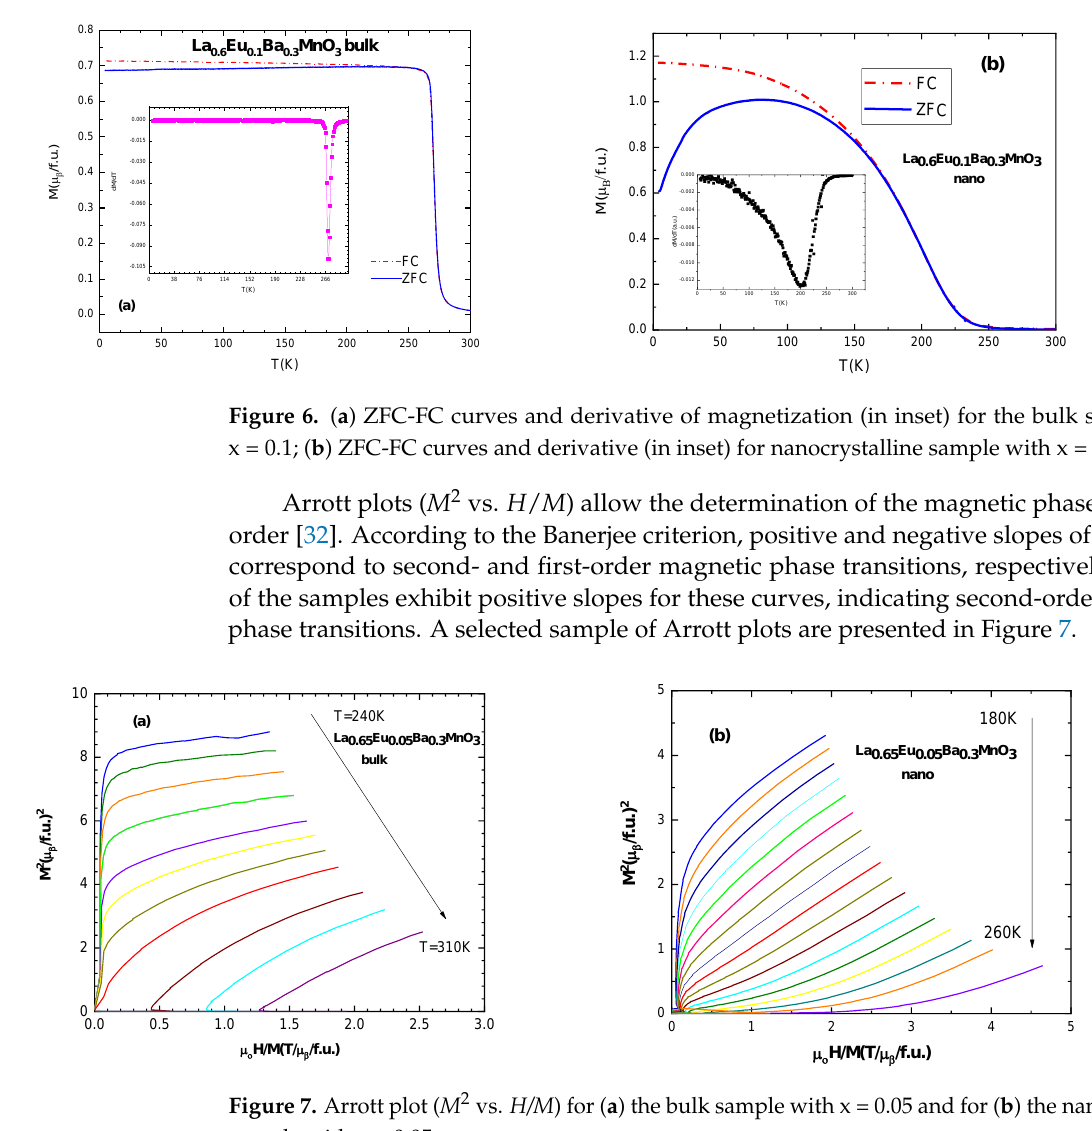
Figure 7. Arrott plot ( M 2 vs. H/M ) for ( a ) the bulk sample with x = 0.05 and for ( b ) the nanocrystalline sample with x = 0.05.